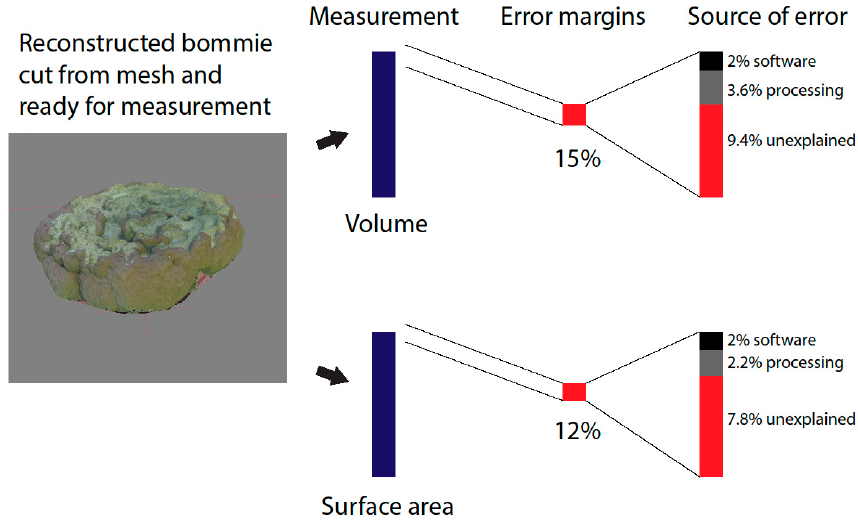
Figure 6. Summary of explained and unexplained measurement error for volume and surface area measurements of structures using structure from motion.